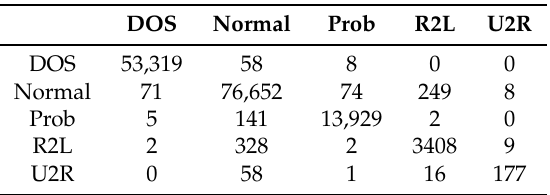
Table 6. Normal and various attacks Confusion Matrix for the NSL-KDD dataset using Random Forest classification.